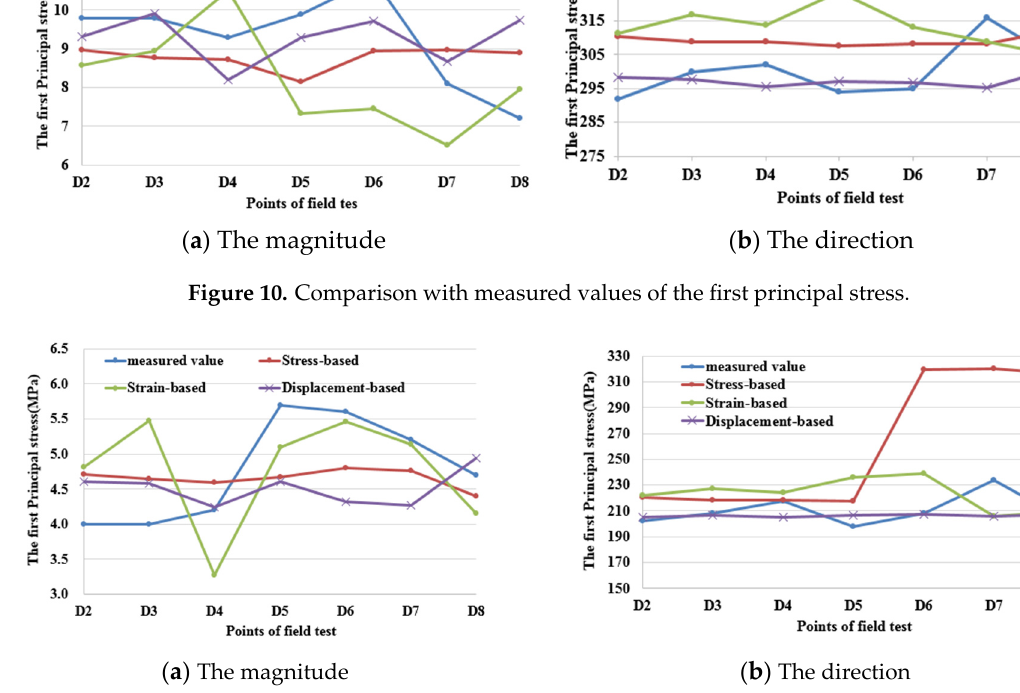
Figure 11. Comparison with measured values of the second principal stress.